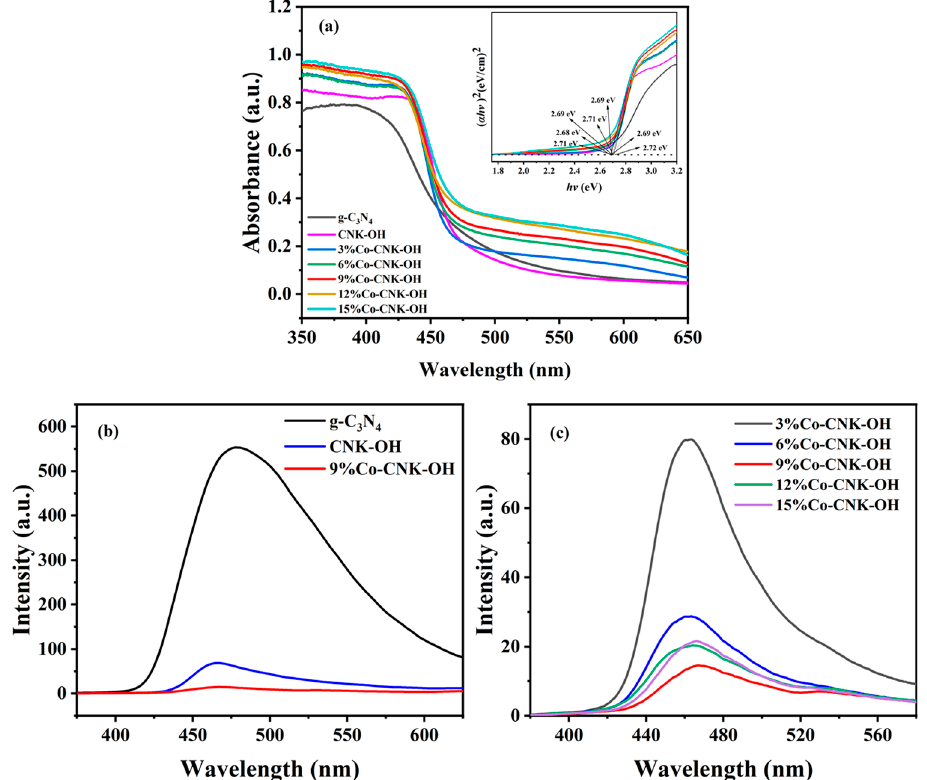
Figure 6. UV-vis di ff use re fl ectance pa tt erns of g-C 3 N 4 , CNK-OH and Co-CNK-OH (outer fi gure), Figure 6. UV-vis diffuse reflectance patterns of g-C 3 N 4 , CNK-OH and Co-CNK-OH (outer figure), plots of ( α hv ) 2 versus hv of g-C 3 N 4 , CNK-OH and Co-CNK-OH (sub- fi gure) ( a ); PL emission spectra plots of ( α hv ) 2 versus hv of g-C 3 N 4 , CNK-OH and Co-CNK-OH (sub-figure) ( a ); PL emission of g-C 3 N 4 , CNK-OH, and 9%Co-CNK-OH ( b ); and PL emission spectra of X%Co-CNK-OH ( c ).